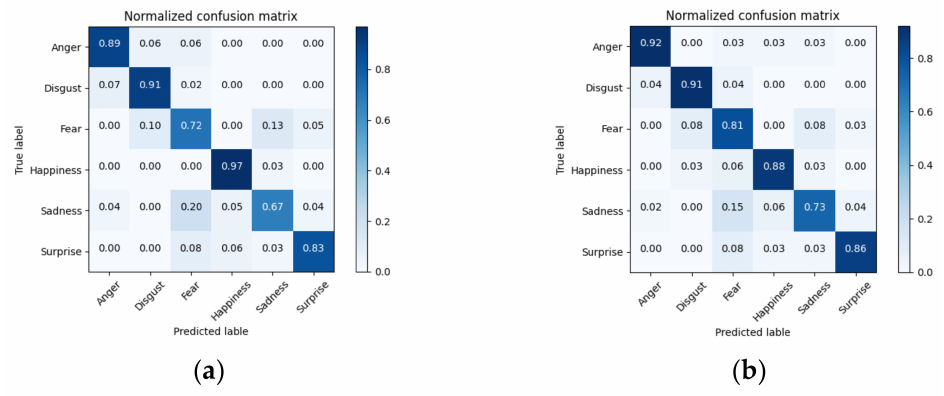
Figure 8. The confusion matrices of different methods on the eNTERFACE’05 dataset: ( a ) baseline; ( b ) our proposed